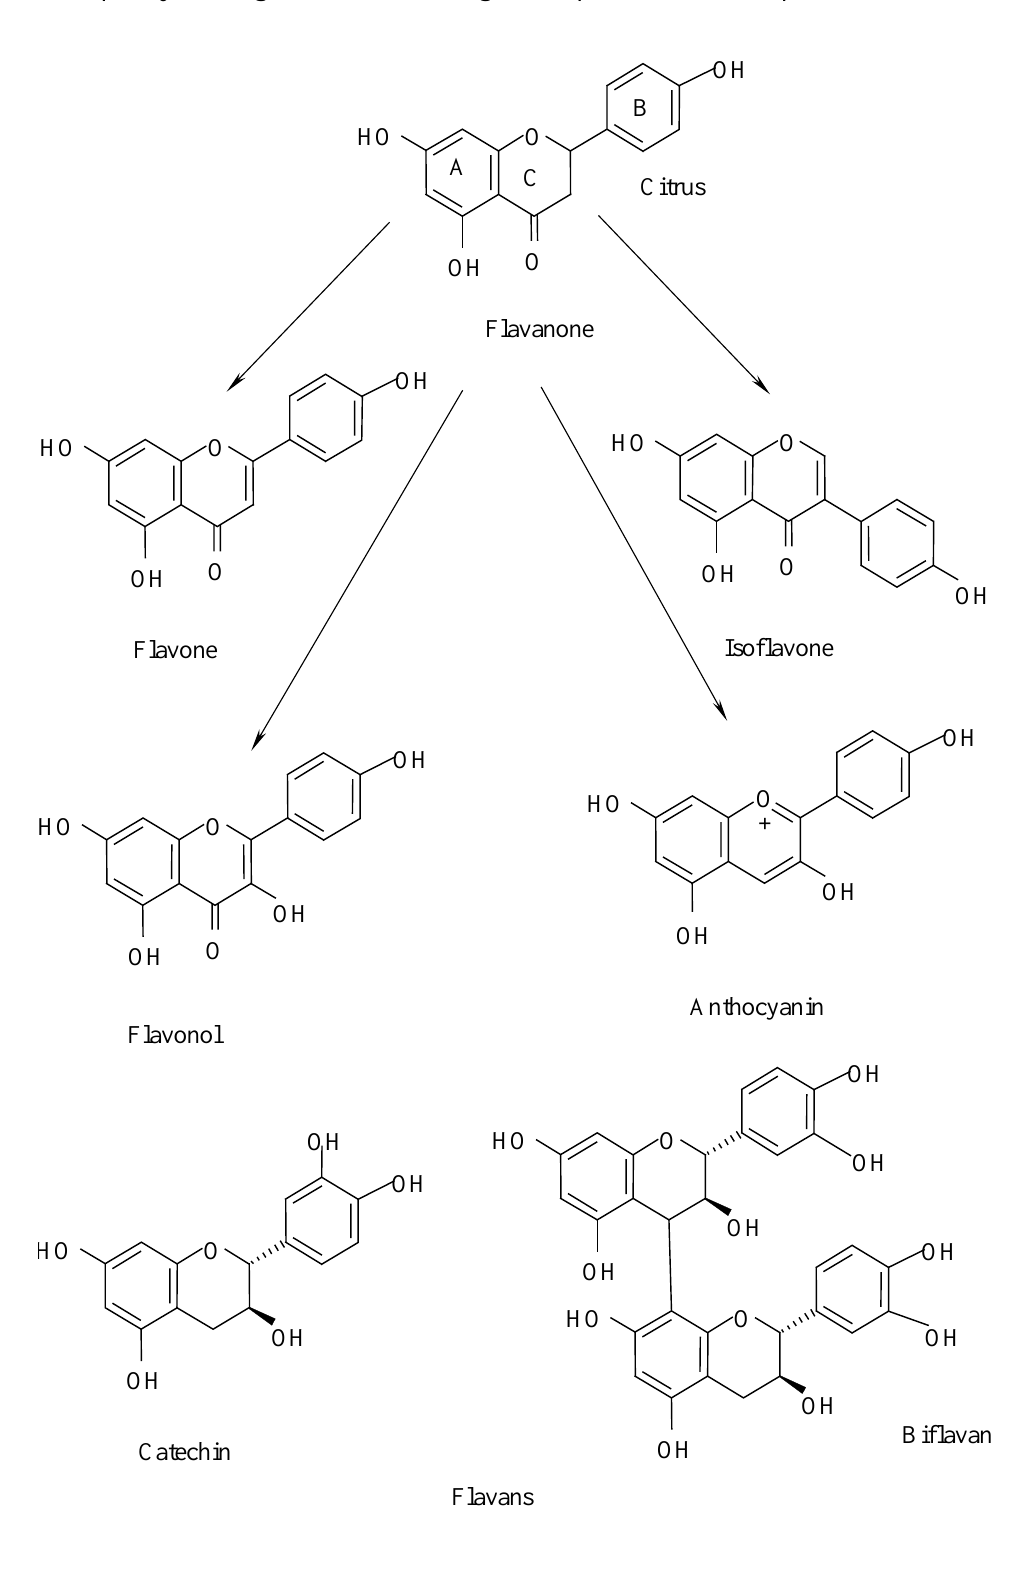
Figure 1. Molecular structures of flavonoids adapted from Peterson and Dwyer (arrows indicate biosynthetic path) [3]. The basic structure consists of the fused A- and C-ring, with the phenyl B-ring attached to through its 1-position to the 2-position of the C-ring.